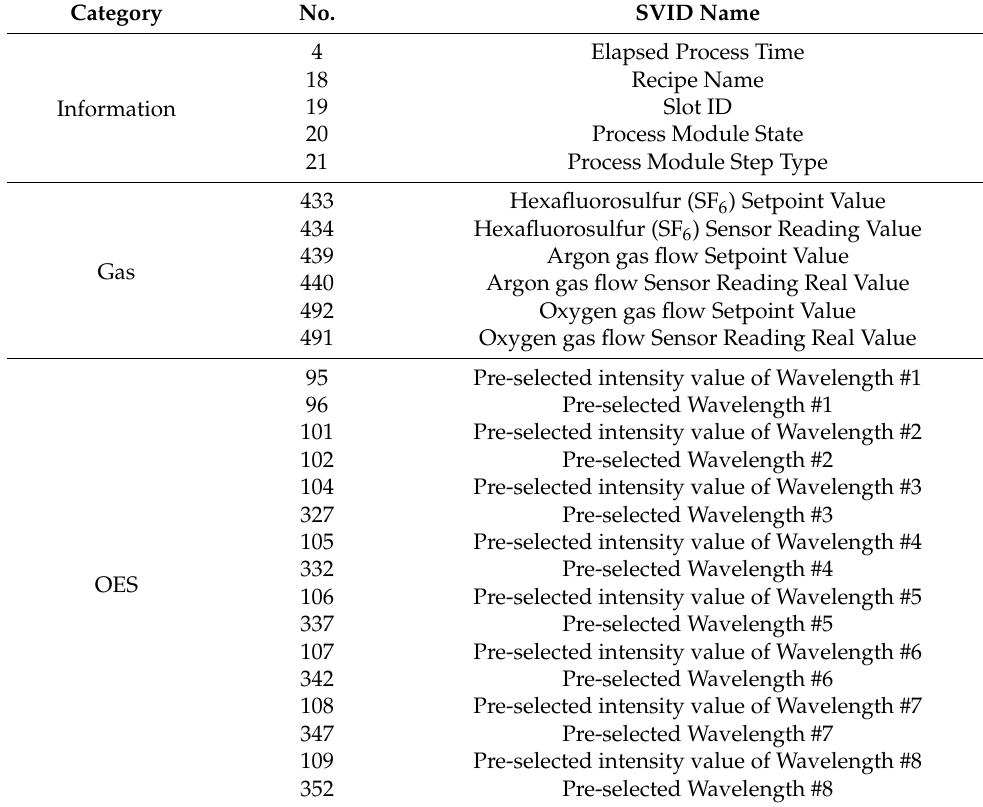
Table 4. List of key equipment state variable identification (SVID) parameters.